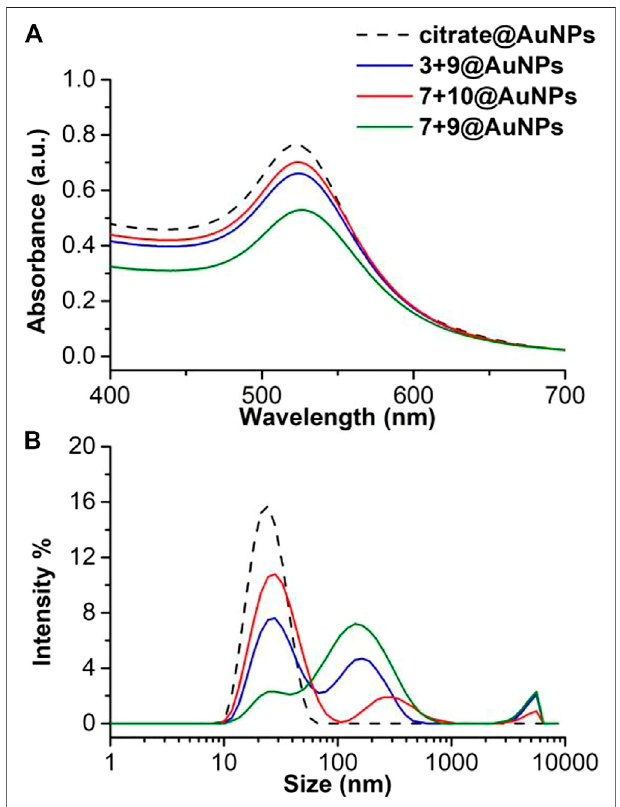
FIGURE 9 | (A) Absorption spectra and (B) size distribution by intensity of citrate@AuNPs (dash) and functionalized-AuNPs with peptides 3 + 9 (blue), 7 + 10 (red), and 7 + 9 (green) after addition of avidin solution (0.0125 mg/ml). Mean DLS results are given for three different measurements. The hydrodynamic diameter is found 22.7 ± 0.2 nm PdI 0.2 ± 0.02 for citrate@ AuNPs, 33 ± 4 and 176.7 ± 19.8 nm PdI 0.6 ± 0.1 for 3 + 9 @AuNPs, 31.4 ±